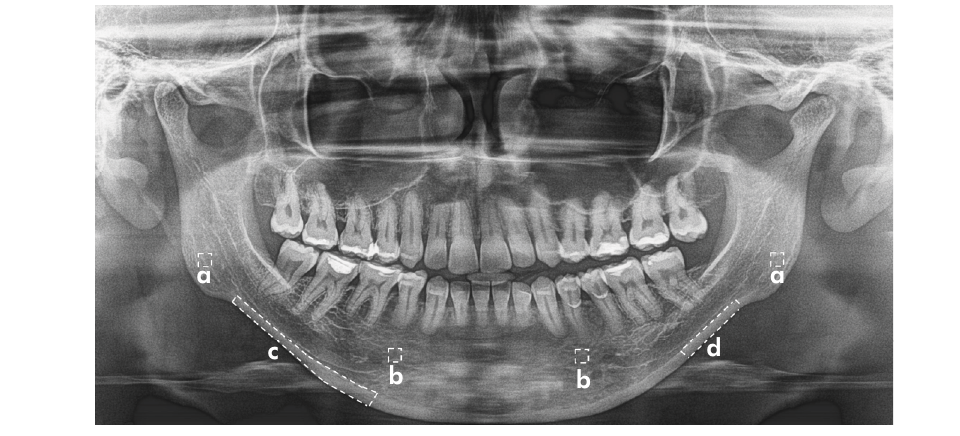
Figure 3. Regions of interest (ROI) used in the fractal dimension. ROI of 50 × 50 pixels were selected on the trabecular bone of the mandibular angle (A) and anterior regions of the premolars (B) . An anatomical ROI was drawn on the mandibular cortical bone with an image overlap of the hyoid bone (C) and without an image overlap of the hyoid bone (D) .